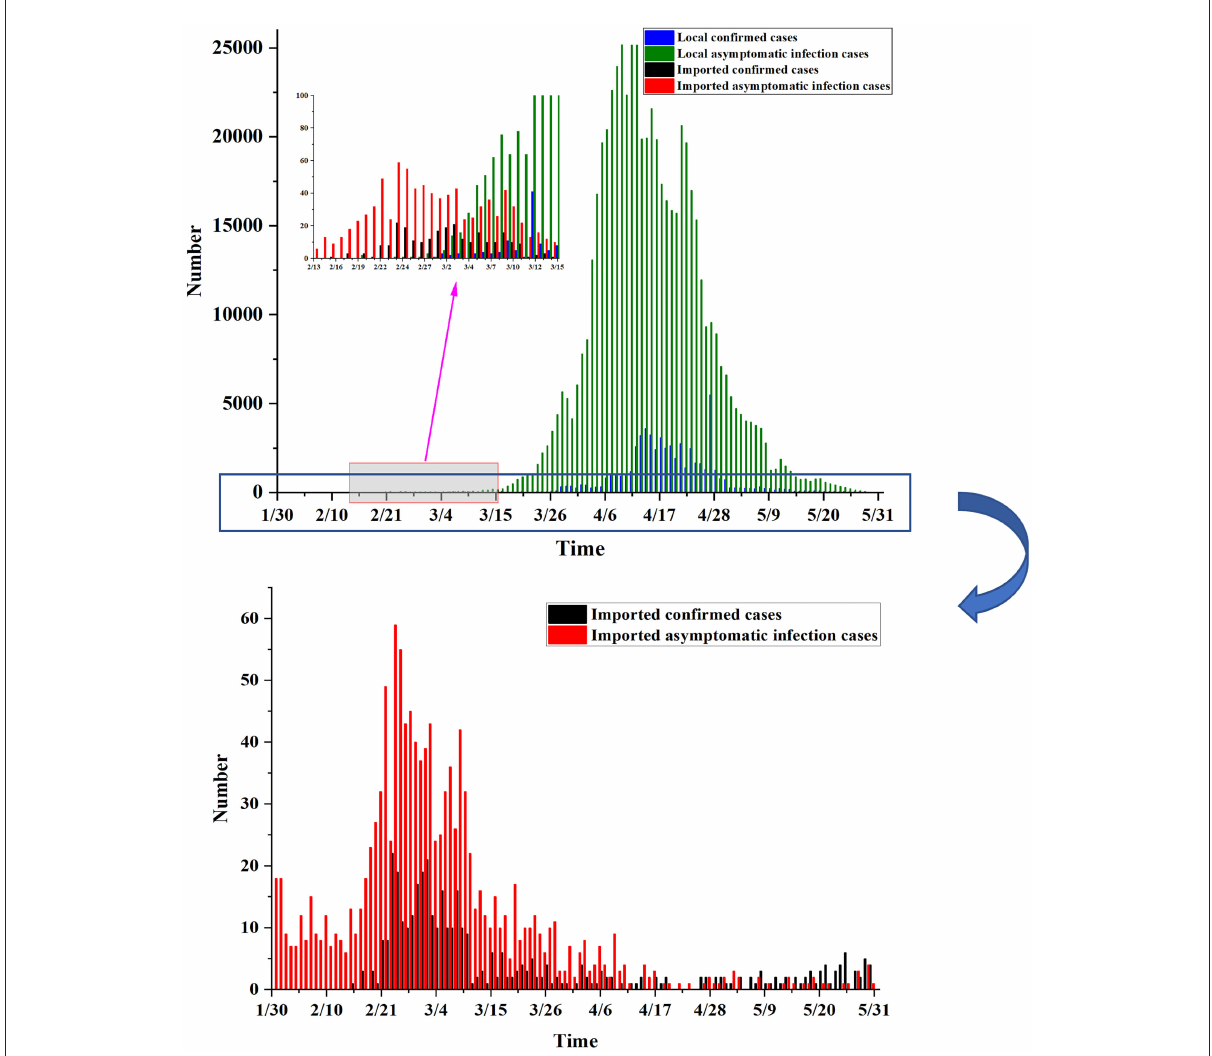
FIGURE4 The temporal distribution of the epidemic. The time of onset and the epidemic curve of the Shanghai epidemic: Based on the daily number of new cases listed on the report date, the cases were divided into local confirmed cases, local asymptomatic infections, imported confirmed cases and imported asymptomatic infections.